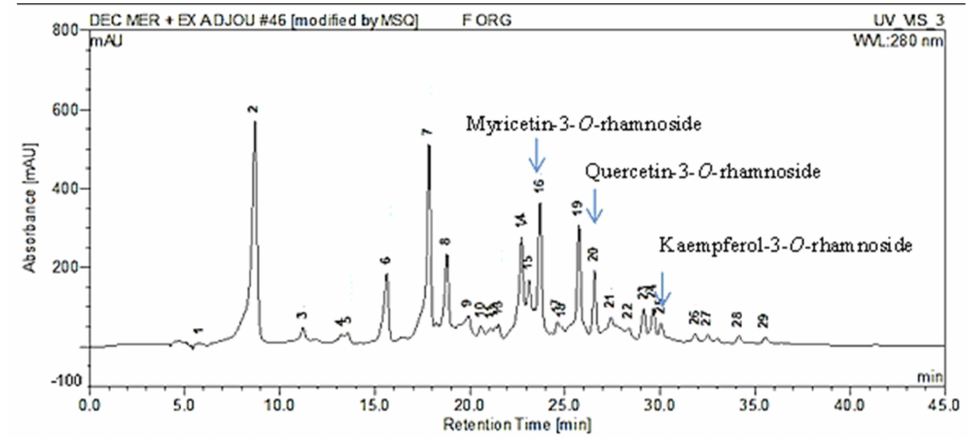
Figure 1. Chromatographic profile of the ethyl acetate extract (EAE) of P. lentiscus L. distilled leaves (PDL) acquired by HPLC-MS, detected at 280 nm. The three major isolated molecules from this extract were mentioned in the figure.